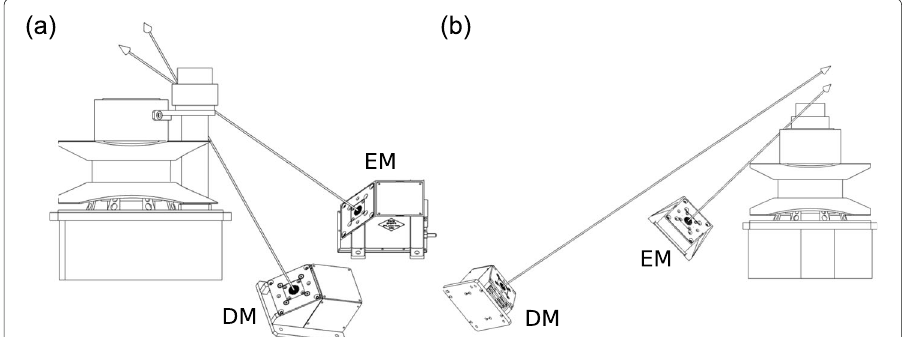
Fig. 14 Configuration for testing of the two versions of the plasma sensor in a chamber with the HEMPT at ThalesDeutschlandGmbH.TheRPAsofbothsensorsroughlypointtothethrusterexit(thesensorsarelabeled “DM” and “EM” for demonstrator and engineering model, respectively). The smaller but longer assembly of the thruster is the neutralizer. The drawings (a) and (b) show the same arrangement from different